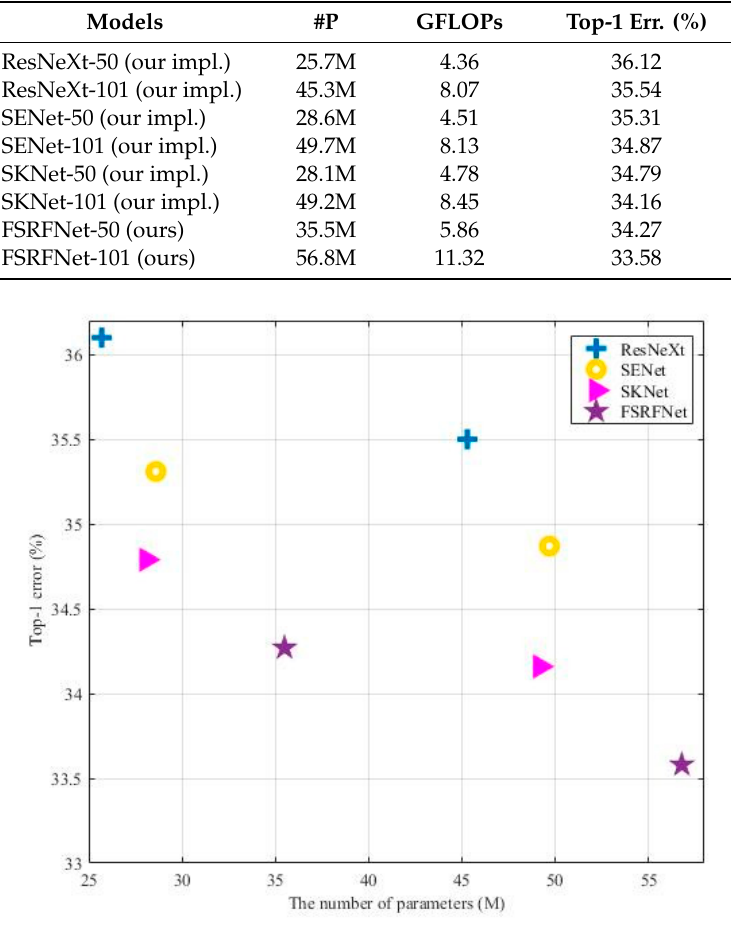
Figure 5. Relationship between the performance of FSRFNet and the number of its parameters, compared with the corresponding ResNeXt backbones.